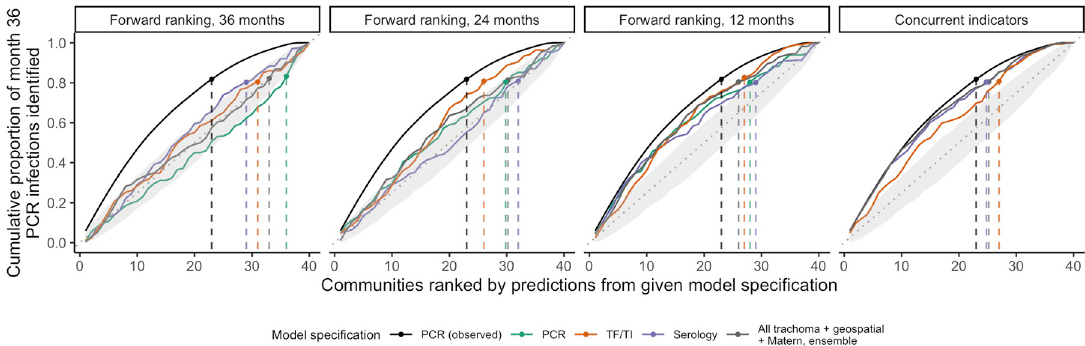
Fig 5. Cumulative proportion of C . trachomatis infections at month 36 identified by concurrent and forward prediction models. Dashed lines indicate the point at which the cumulative proportion of identified Ct infections at month 36, scaled to represent a sample of 30 individuals per community, surpassed 80%. The black line in each facet represents the optimal ordering of scaled PCR infections at month 36. To simulate a null distribution, we estimated the cumulative proportion of infections identified for 1000 random orderings of the 40 communities and plotted the 95% pointwise envelope (gray shading). For concurrent and 24-month-forward predictions, models using serology only and PCR only, respectively, performed equally well to a model using all trachoma indicators, geospatial features, a Mate´rn covariance, and ensemble machine learning; vertical lines were offset slightly for visibility.